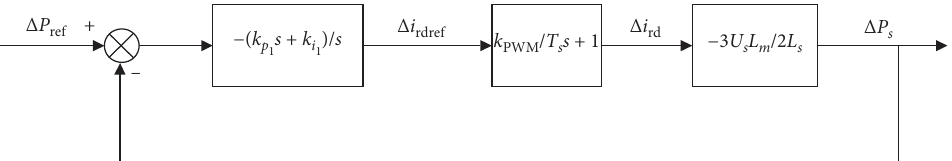
Figure 12: Power control closed loop.